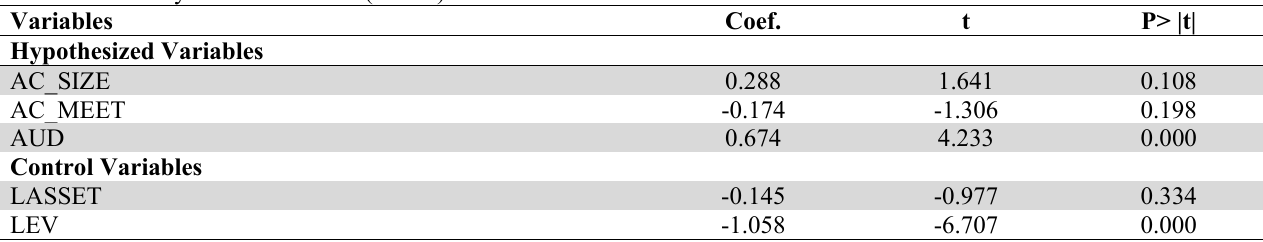
Pooled OLS Analysis Results–ROA (n =